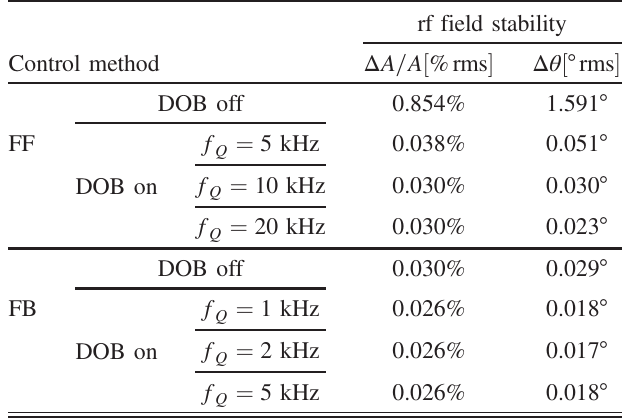
TABLE VI. Improvement of DOB control on FF and FB